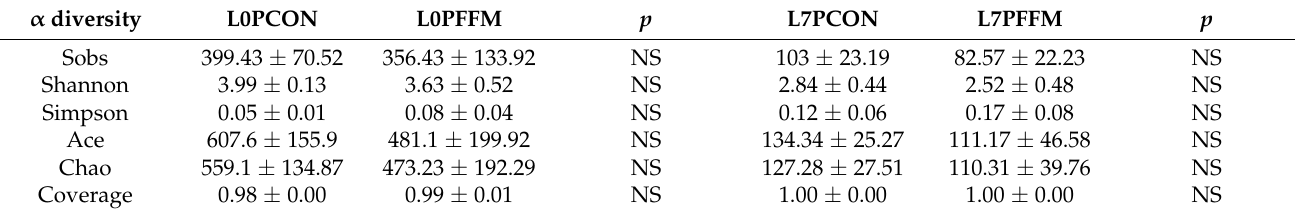
Table 4. α diversity values of piglets’ feces on L0 and L7.